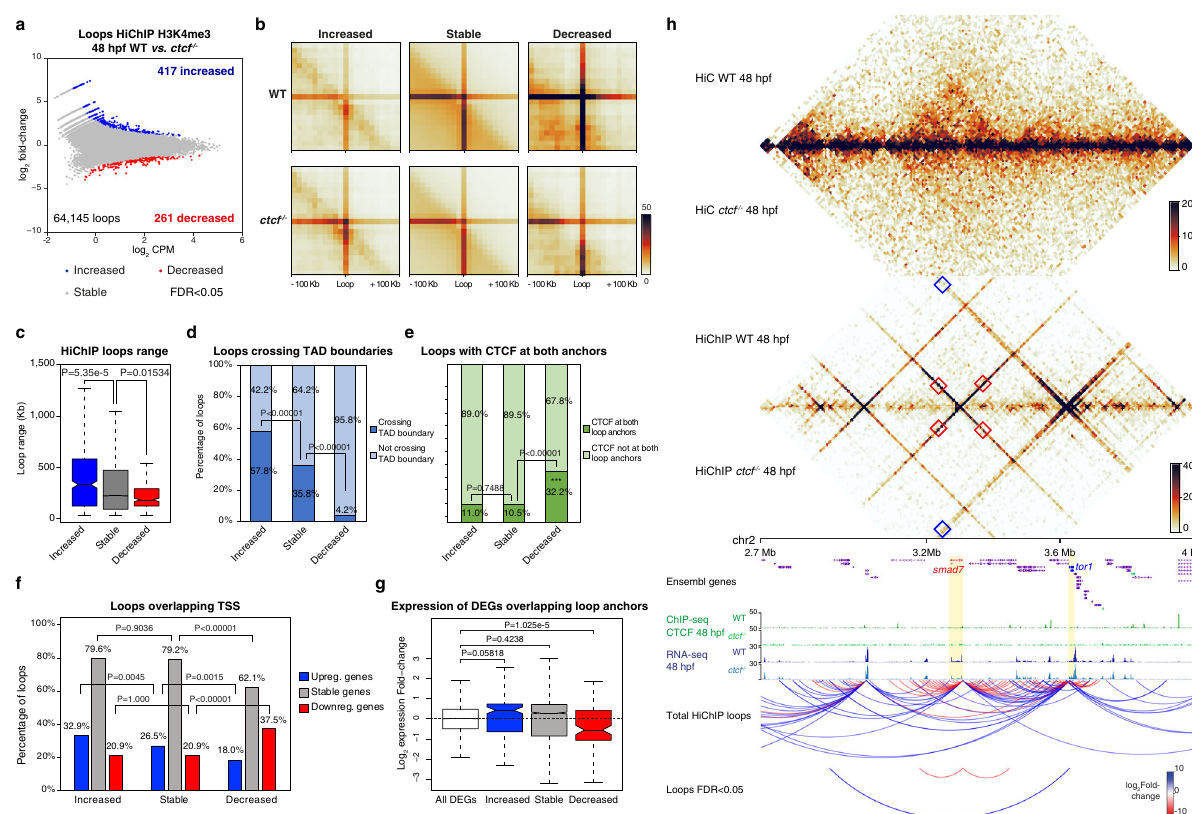
Fig. 3 Differential promoter looping is associated with gene miss-expression. a Differential analysis of H3K4me3 HiChIP loops between WT and ctcf − / − embryos at 48 hpf ( n = 2 biological replicates per genotype) at 10-kb resolution. The log 2 normalized counts per million (CPM) of WT reads versus the log 2 fold-change of expression are plotted. Loops showing a statistically signi fi cant differential intensity (FDR < 0.05) are highlighted in blue (increased) or red (decreased). b Aggregate peak analysis centered at HiChIP loops for increased, stable and decreased loops in WT and ctcf − / − embryos. c Boxplots showing the distance between loop anchors (loop range) for increased, stable, and decreased loops. d Percentage of loops crossing WT topologically associating domain (TAD) boundaries for increased, stable, and decreased loop categories. e Percentage of loops showing CTCF binding at both anchors for increased, stable, and decreased loops. f Percentage of loops overlapping with the TSS of upregulated, stable, or downregulated genes for the respective loop categories. g Box plots showing the expression fold-change in ctcf − / − embryos at 48 hpf of all DEGs and those associated with increased, stable, and decreased loops. h , From top to bottom, heatmaps showing HiC and H3K4me3 HiChIP signal, tracks with CTCF ChIP-seq and RNA-seq, total analyzed HiChIP loops and differential loops (FDR < 0.05), for WT and ctcf − / − embryos at 48 hpf in a 1.3-Mb region of chromosome 2 containing the downregulated gene smad7 and the upregulated gene tor1 . Boxplots in c and g show center line, median; box limits, upper and lower quartiles; whiskers, 1.5× interquartile range; notches, 95% con fi dence interval of the median. Statistical signi fi cance was assessed using a two-sided Wilcoxon ’ s rank-sum test in ( c ) and ( g ), and with a two-sided Fisher ’ s exact test in ( d – f